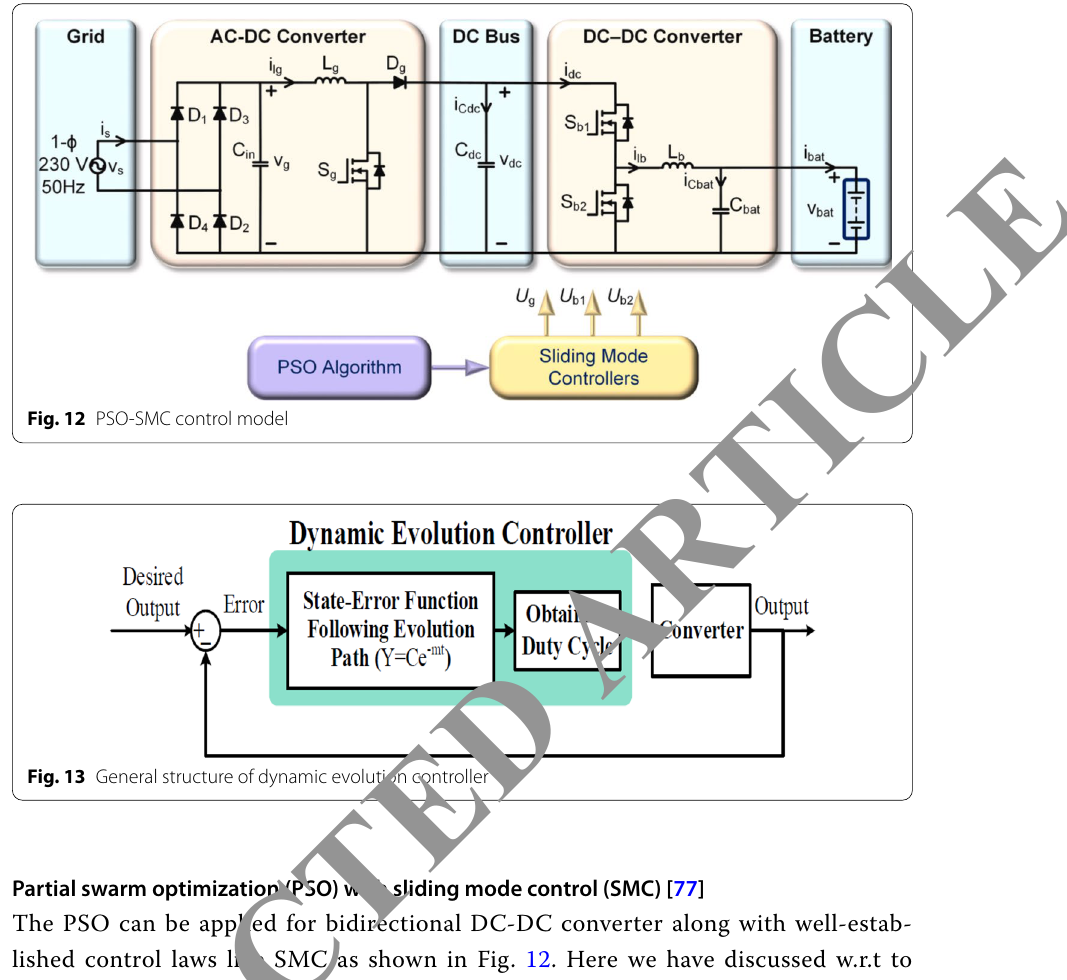
Fig. 13 General structure of dynamic evolution